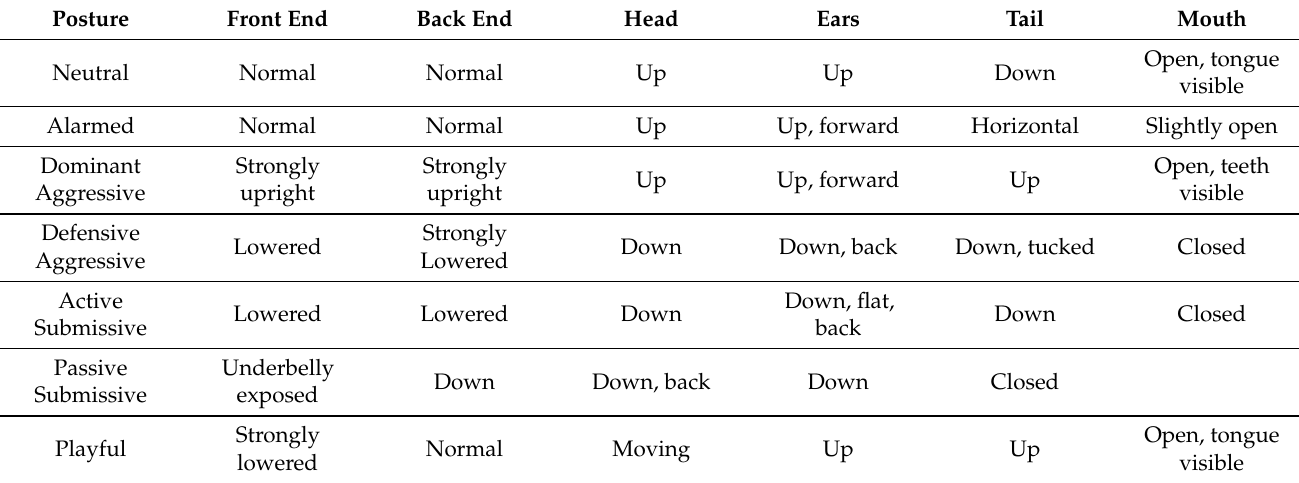
Table 3. Dog posture characteristics [26,27].